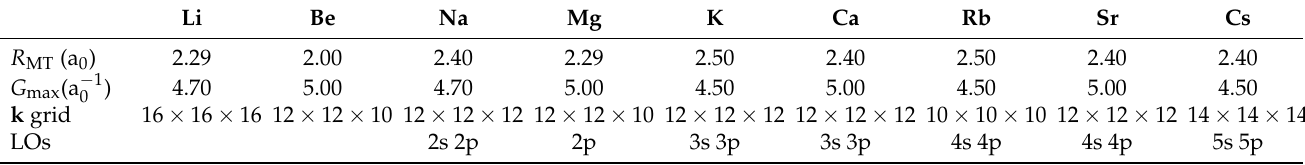
Table 2. Computational parameters.